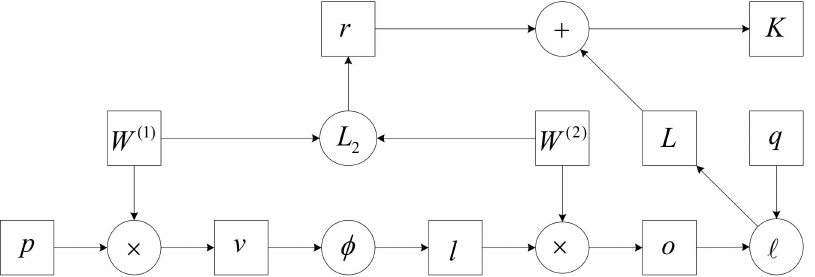
Figure 14. Computational diagram of forward